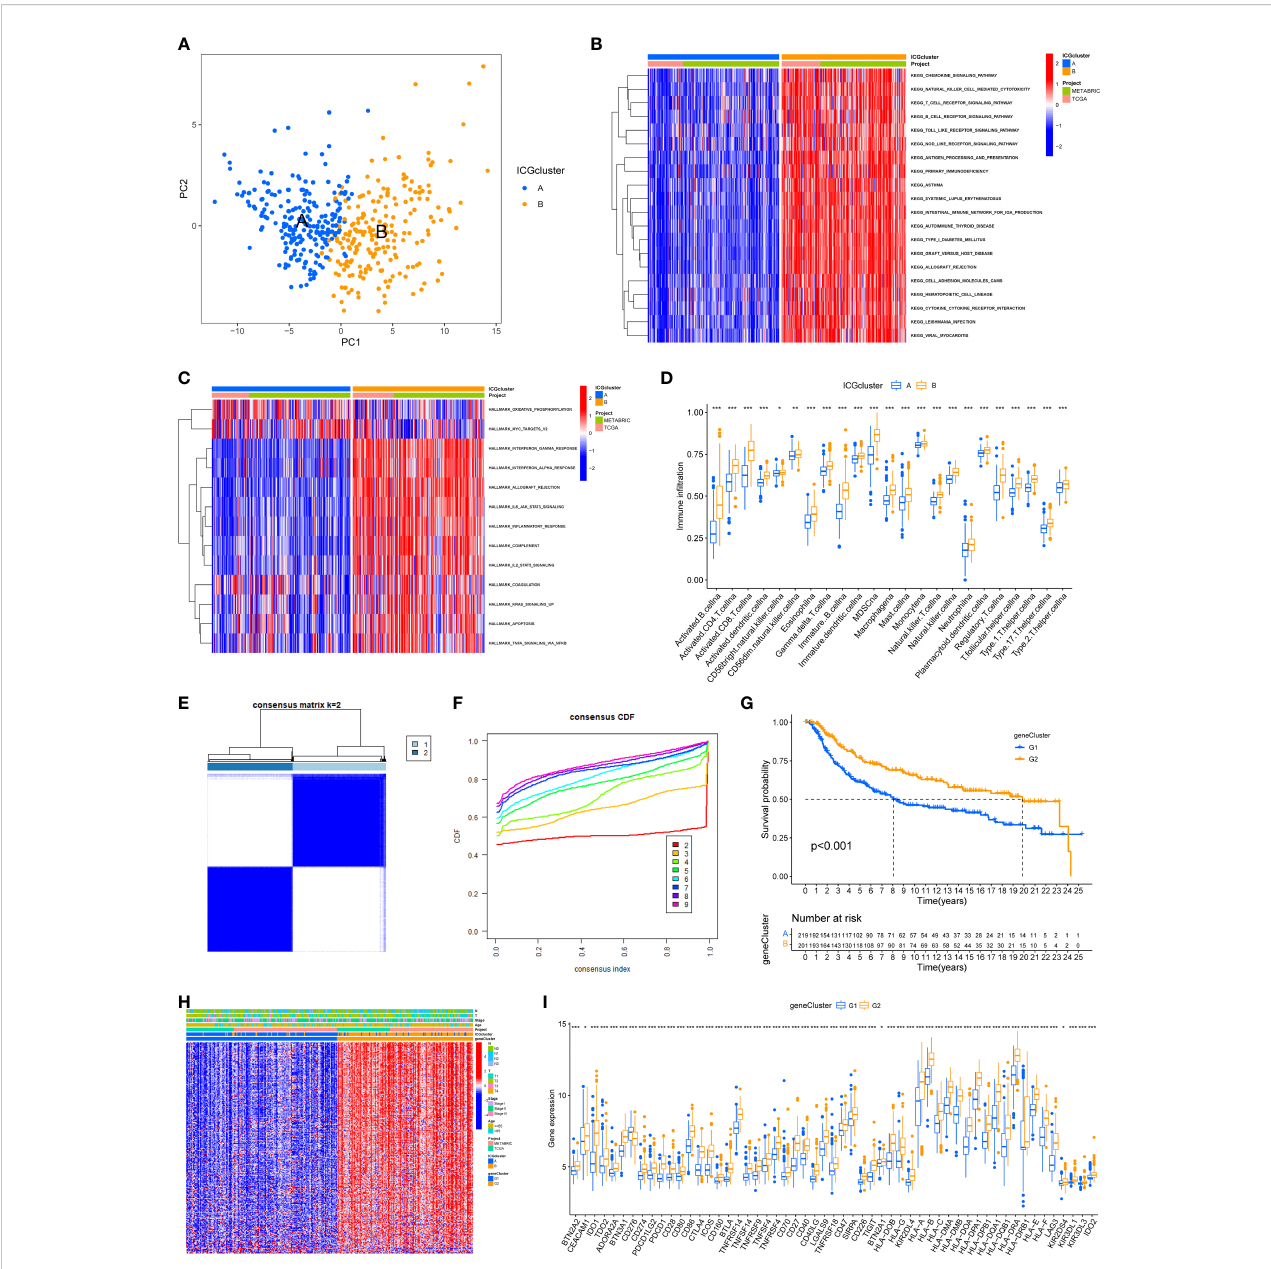
FIGURE 2 Identi fi cation of ICGs-related geneclusters in TNBC. (A) Principal component analysis of two immune checkpoint patterns, showing a remarkable difference between different patterns. (B) Heat map showed the GSVA score of KEGG pathways in two ICGs subtypes. Red indicated activated pathways, and blue indicated inhibited pathways. (C) Heat map showed the GSVA score of Hallmark signature in two ICGs subtypes. Red indicated high enrichment Hallmark. (D) The abundance of each in fi ltrating immune cells in two ICGs clusters. The lines in the boxes indicated the median value. The top and bottom ends of the boxes were interquartile range of values. (E, F) The identi fi cation of ICGs geneClusters by consensus clustering matrix for k = 2. (G) The survival curves of the ICGs geneClusters were plotted by the Kaplan-Meier plotter. The numbers of patients in geneCluster G1 and geneCluster G2 subtypes are 219 and 201. (H) Unsupervised clustering of prognostic ICGs-related DEGs to divide patients into two genomic subtypes. The ICGs geneClusters, ICGs clusters, datasets, age stage and survival status were used as patient annotations. (I) The expression of ICGs in two ICGs geneClusters (*P < 0.05; **P < 0.01; ***P <